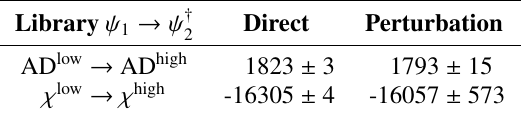
Table 1. Perturbation results on PMF001, values are in